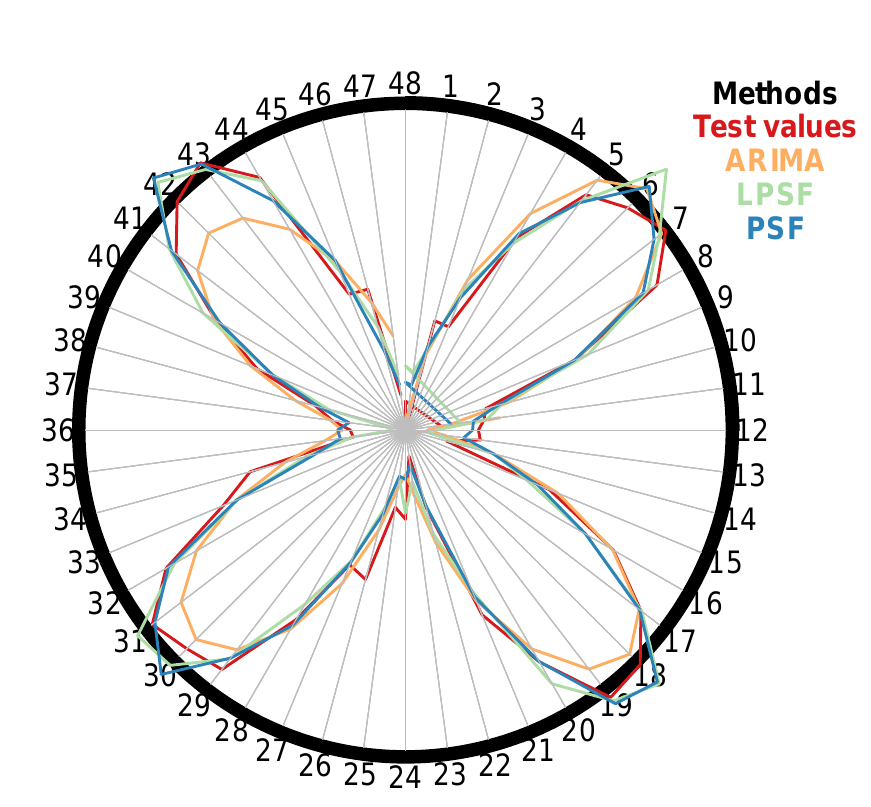
Figure 4. A polar plot to represent forecasted